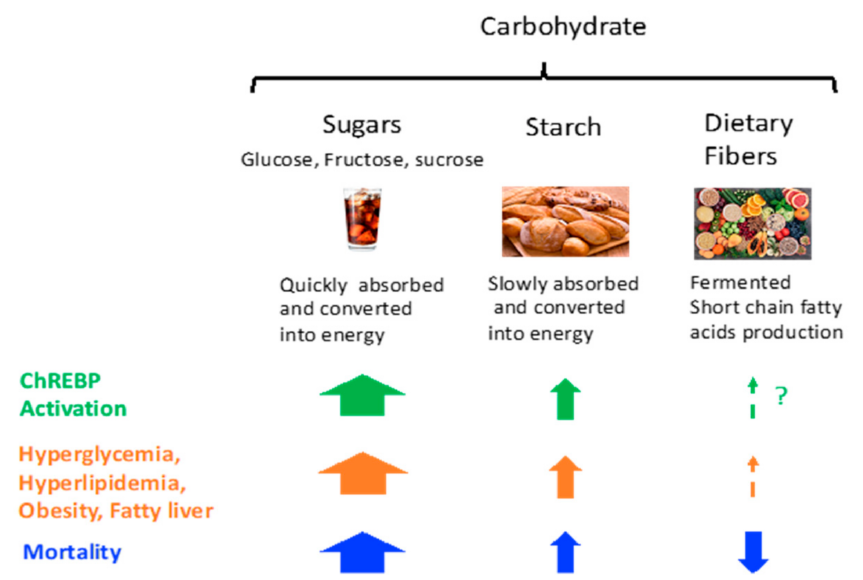
Figure 5. Carbohydrate intake and ChREBP activity, metabolic syndrome, and mortality. Sugars potently activate, starch modestly activates, and dietary fiber probably weakly activates ChREBP. The relationship between carbohydrate intake and ChREBP activity is similar to those of metabolic syndrome (hyperglycemia, hyperlipidemia, obesity, and fatty liver) and mortality. ? implies that its effect is not yet evaluated or probably